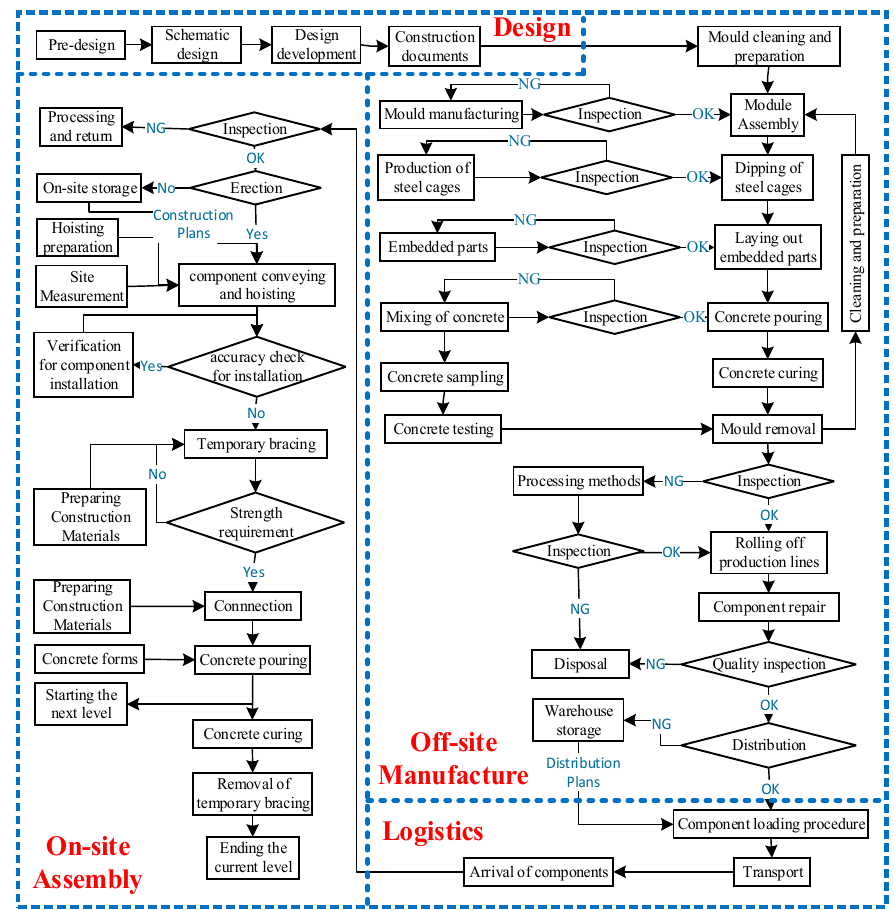
Figure 1. Flowchart of prefabricated construction process.